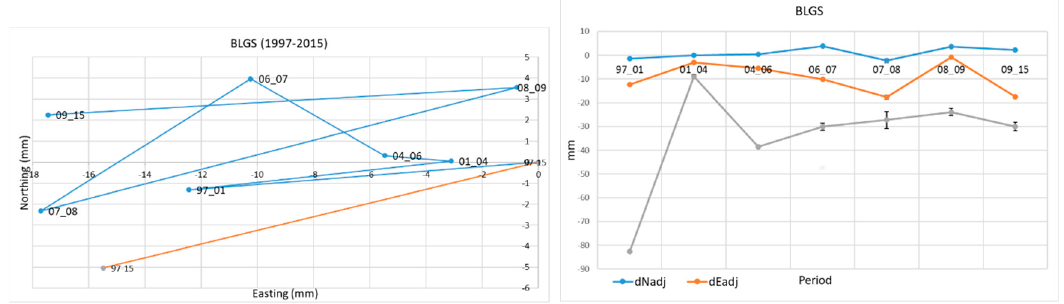
Figure 10. Point BLGS. Larger movements with opposite direction (movement of Zelinska gora). Larger movement values 2008–2009 and 2009–2015.